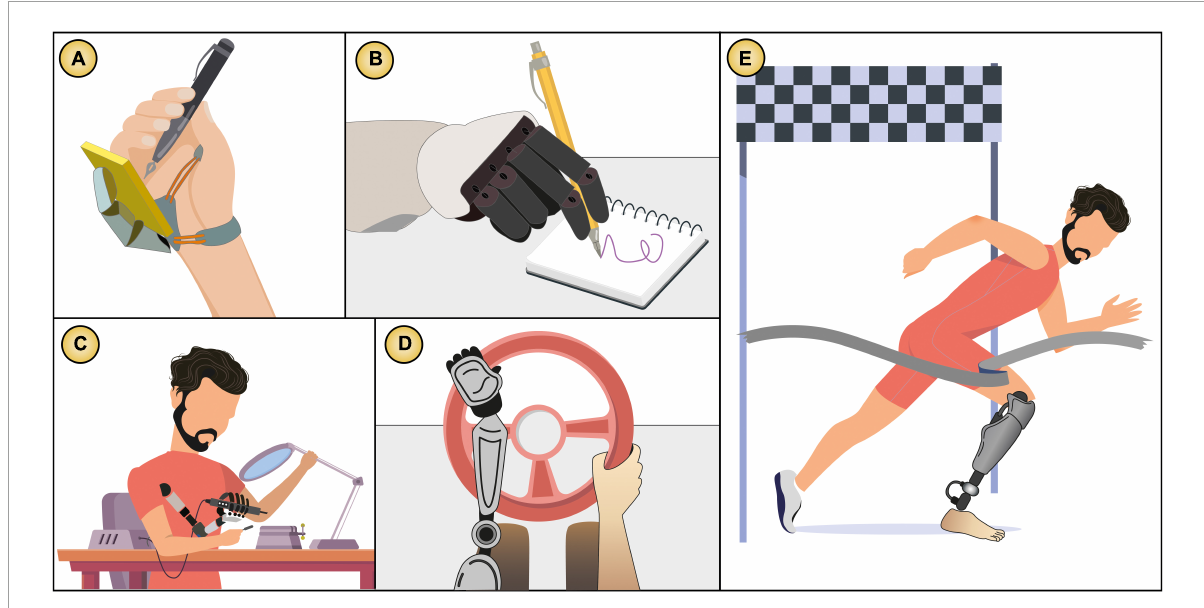
FIGURE7 Examples of body augmentation technology that becomes action augmentation technology. Extra limbs and prosthetic technology that not only provide motor control but also help the user to perform complex tasks and achieve goals in the external world. (A) Royal College of Arts (2021), (B) Open Bionics (2021), (C) Sasaki et al. (2017), (D) Arm Dynamics (2020), (E) Prosthesis used in the Paralympics. Images based on the original publications.